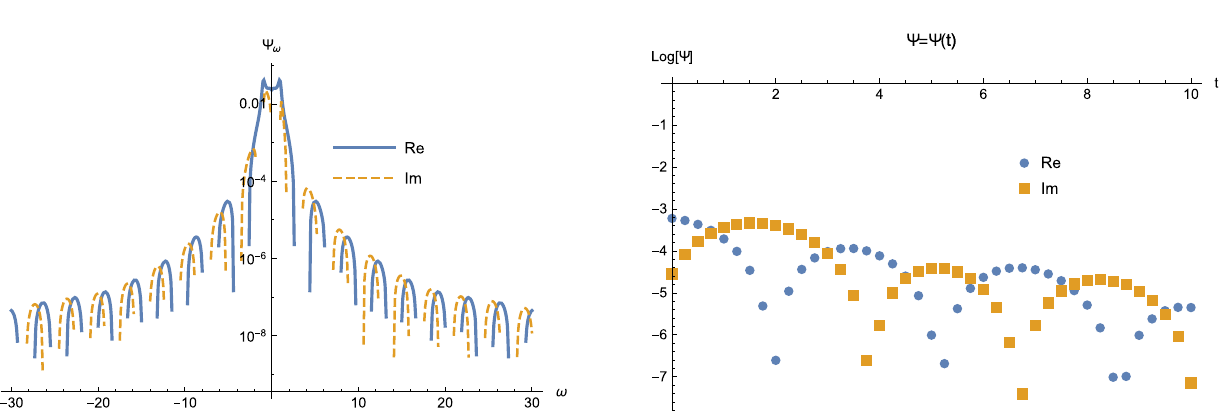
Fig. 3 ResultsonmasslessscalarperturbationsinKerrblackholemet- ric with external source. Left: The real and imaginary parts of the mas- ter equation’s numerical solution in the frequency domain, evaluated at